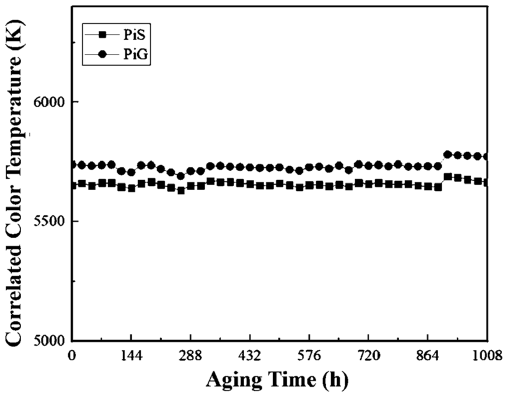
Figure 5. CCT drift of PiS WLED and PiG WLED at 350 mA for 1008 h.